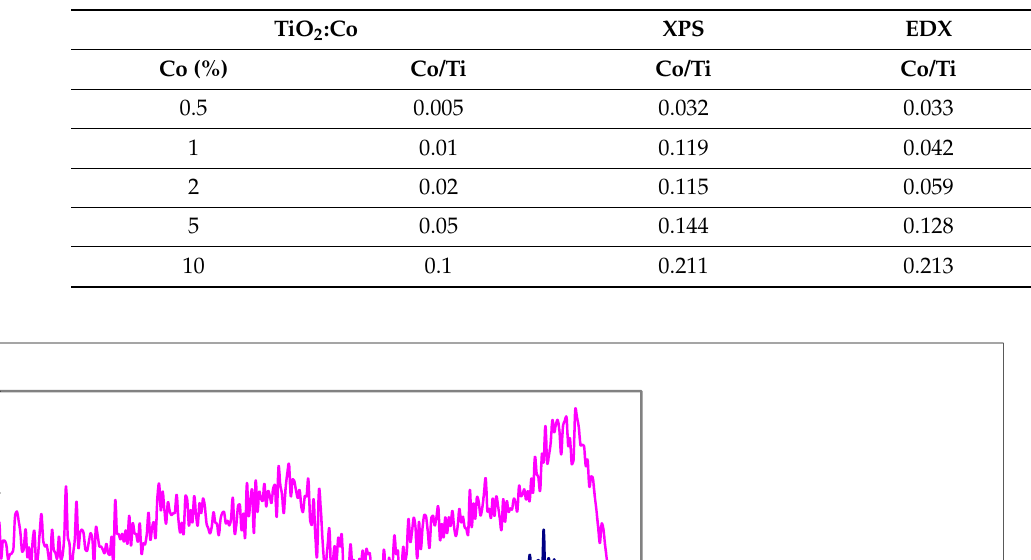
Table 1. Results of composition analysis by XPS and EDX of Co–doped TiO 2 samples.